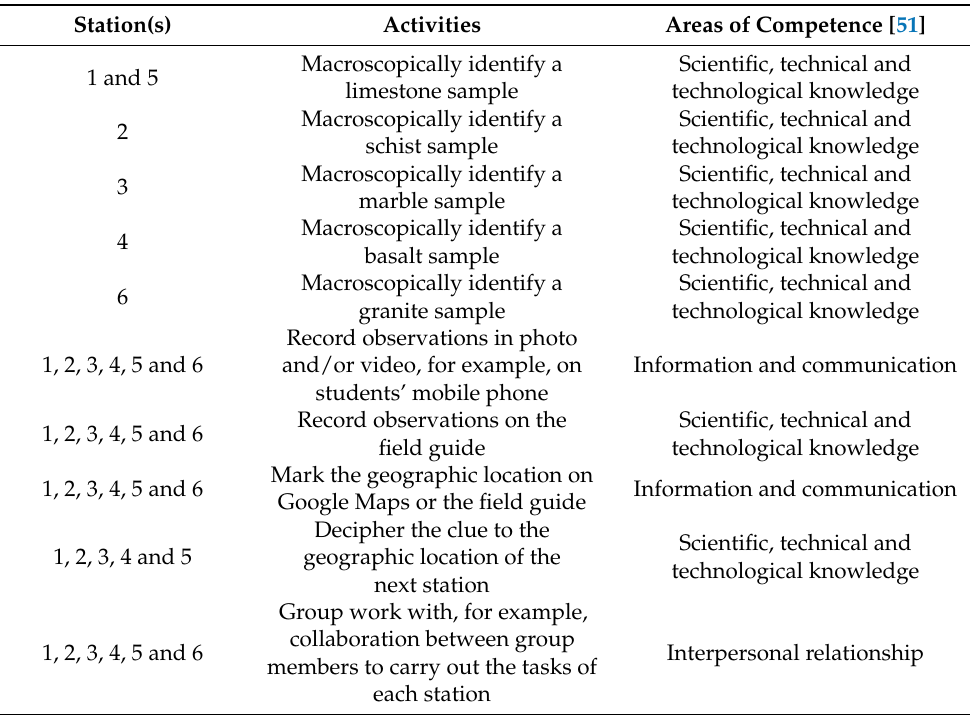
Table 1. Activities to be carried out by students on the field trip and areas of competence [51] that can be